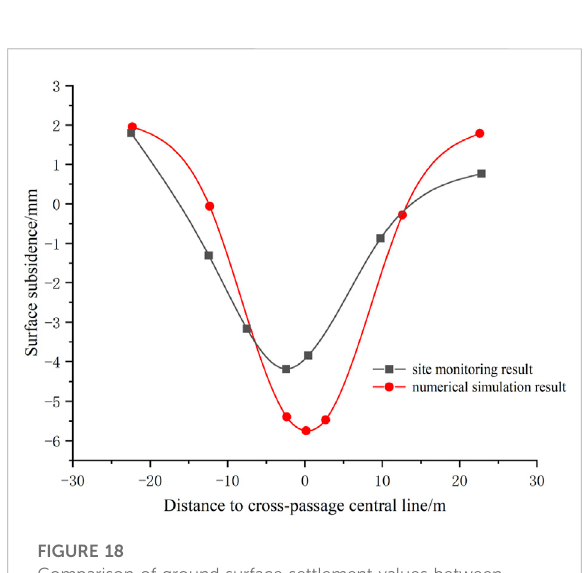
FIGURE 18 Comparison of ground surface settlement values between numerical analysis and site monitoring for Section